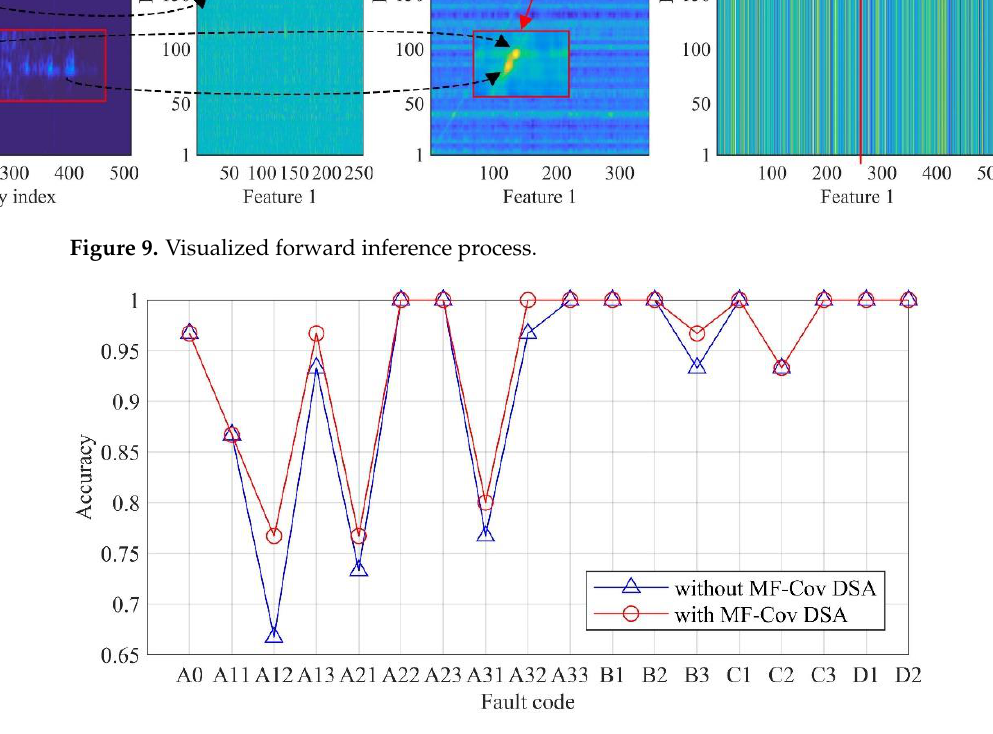
Figure 9. Visualized forward inference process.